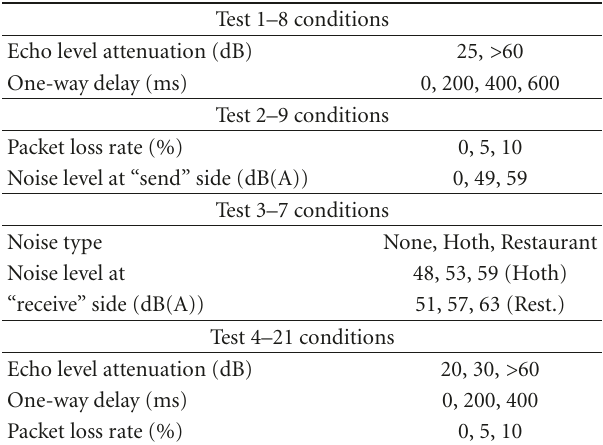
Table 2: Tests conditions. Table 3: Experimental